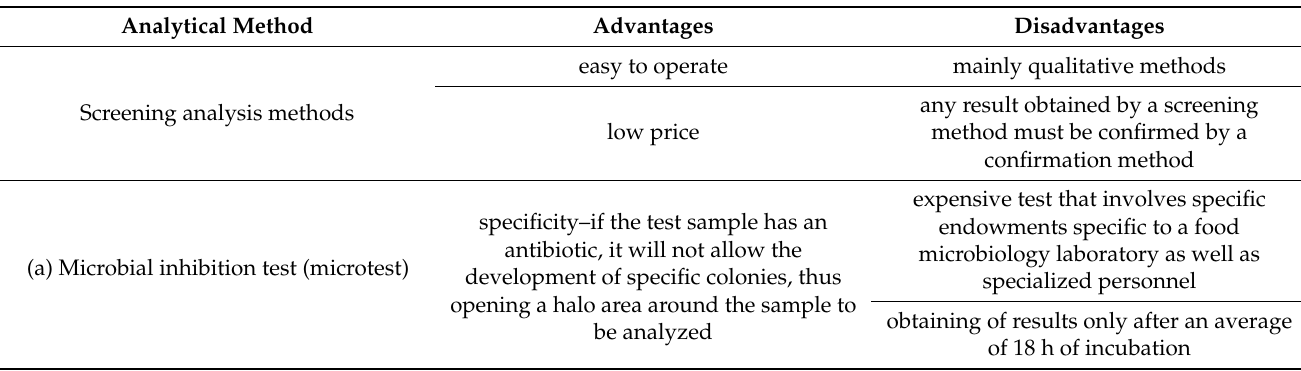
Table 3. Advantages and disadvantages of different analysis